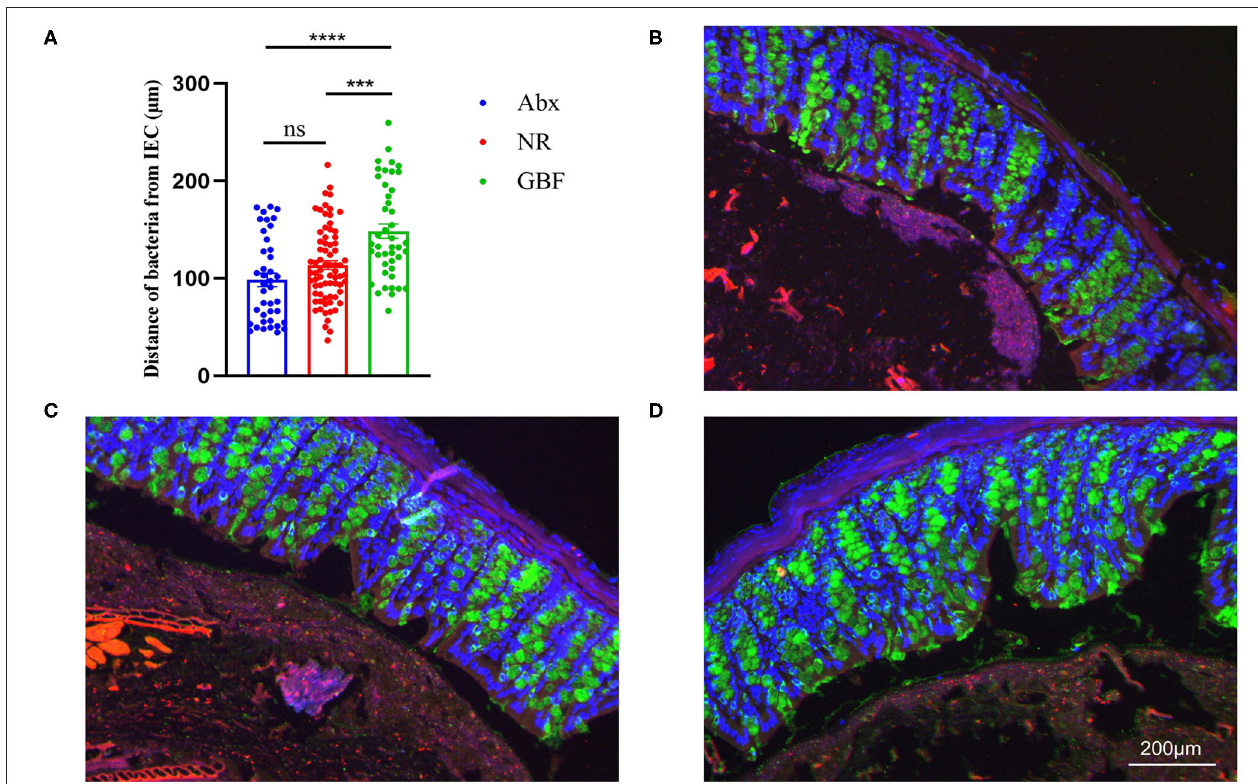
FIGURE 2 | Bacteria localization analysis. (A) Distances of closest bacteria to intestinal epithelial cells per condition. (B–D) Representative pictures of microbiota localization. (B) Antibiotics (Abx) treatment. (C) Natural recovery (NR) group after recovery treatment. (D) Green banana flour (GBF) group after recovery treatment. Mucin-2, green; bacteria, red; and DNA, blue. Significance was determined using a one-way ANOVA corrected for multiple comparisons with the Tukey’s test. The values were expressed as the means ± SEM, n = 6 per group, 6 fields per mouse. *** P < 0.001, **** P < 0.0001. ns indicated comparisions that were not